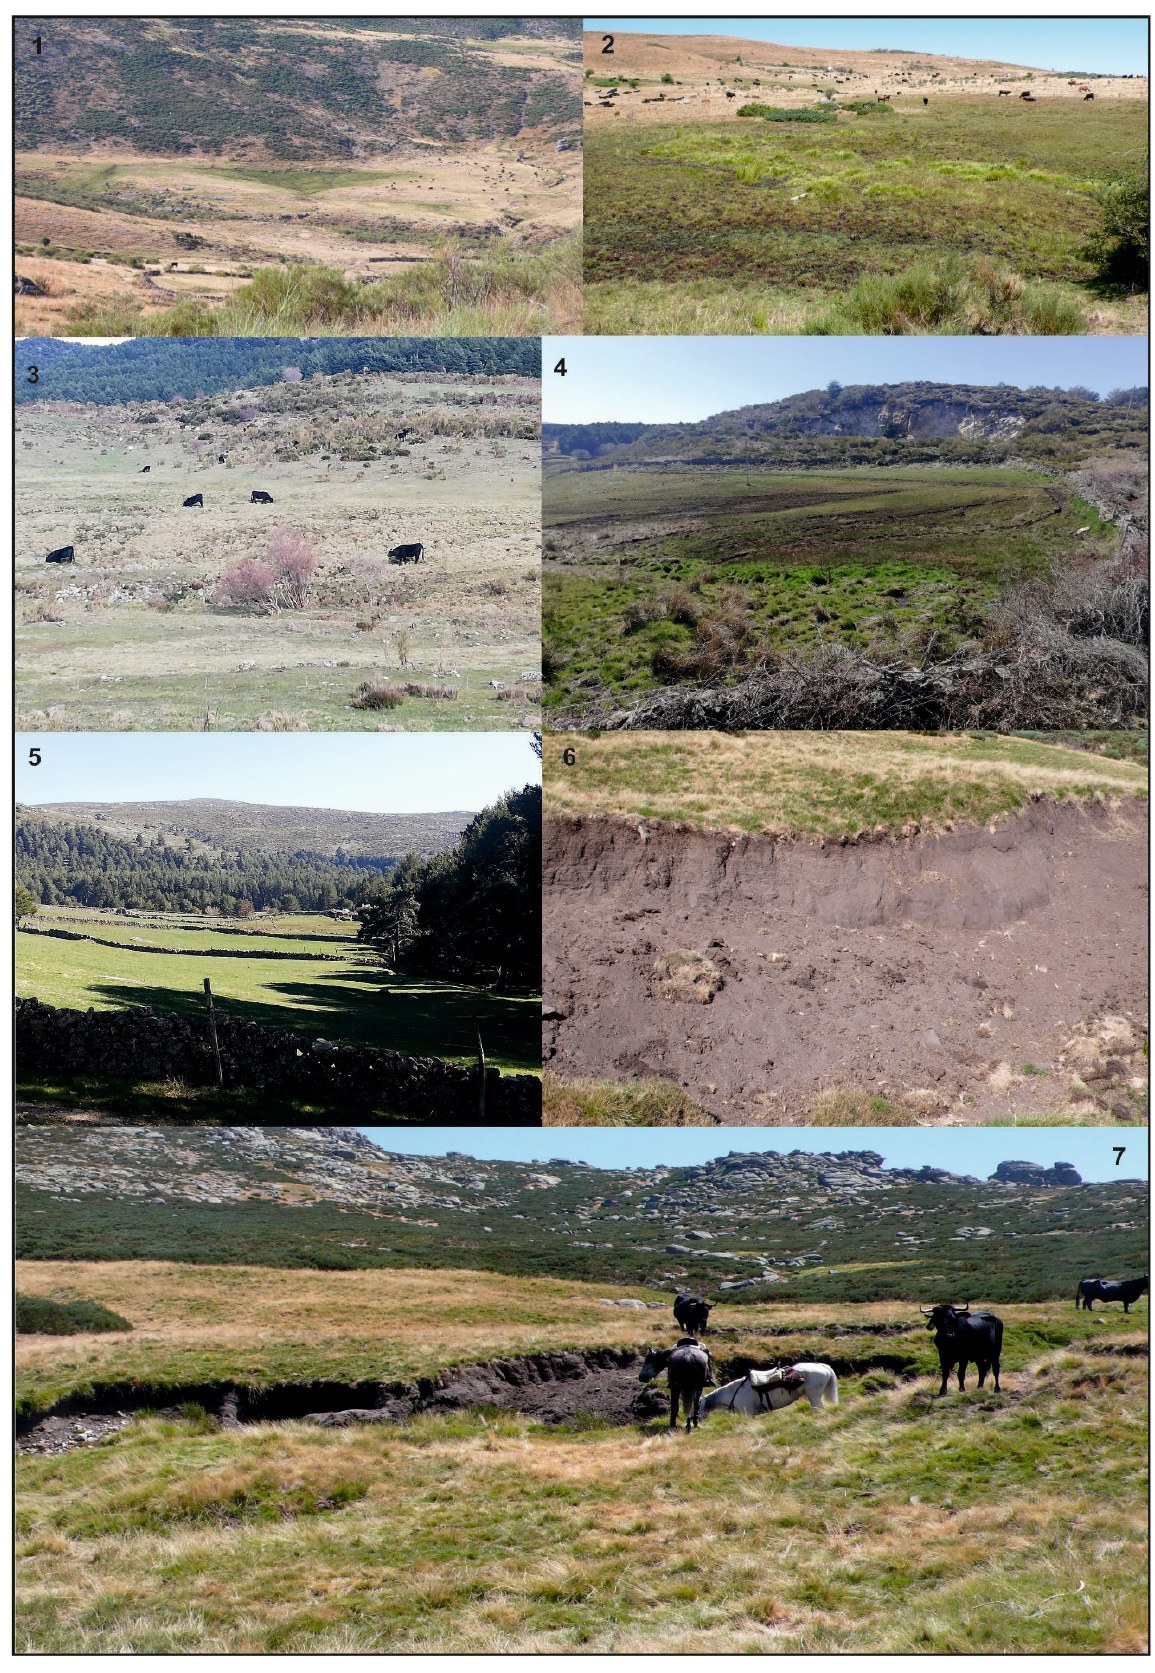
Figure 6. Some examples of the main threats to the peatlands of the Gredos Regional Park: a) Overgrazing and floristic impoverishment (1, Corral de la Covacha; 2, Fuente de la Leche; 3, Venta Rasquilla); b) Navarredonda (4) and Casas de la Isla (5) peatlands are home to one of the few known populations of Meesia triquetra in the GRP, a species included in the IUCN Red List with the CR category as “critically endangered”. Both are subject to very high pastoral pressure in the form of grazing and trampling by domestic livestock, which puts this species at serious risk. The second of the two peatlands is also drained; c) erosion and exposure of extensive areas of bare peat (6, Collado Viejo; 7, Puerto del